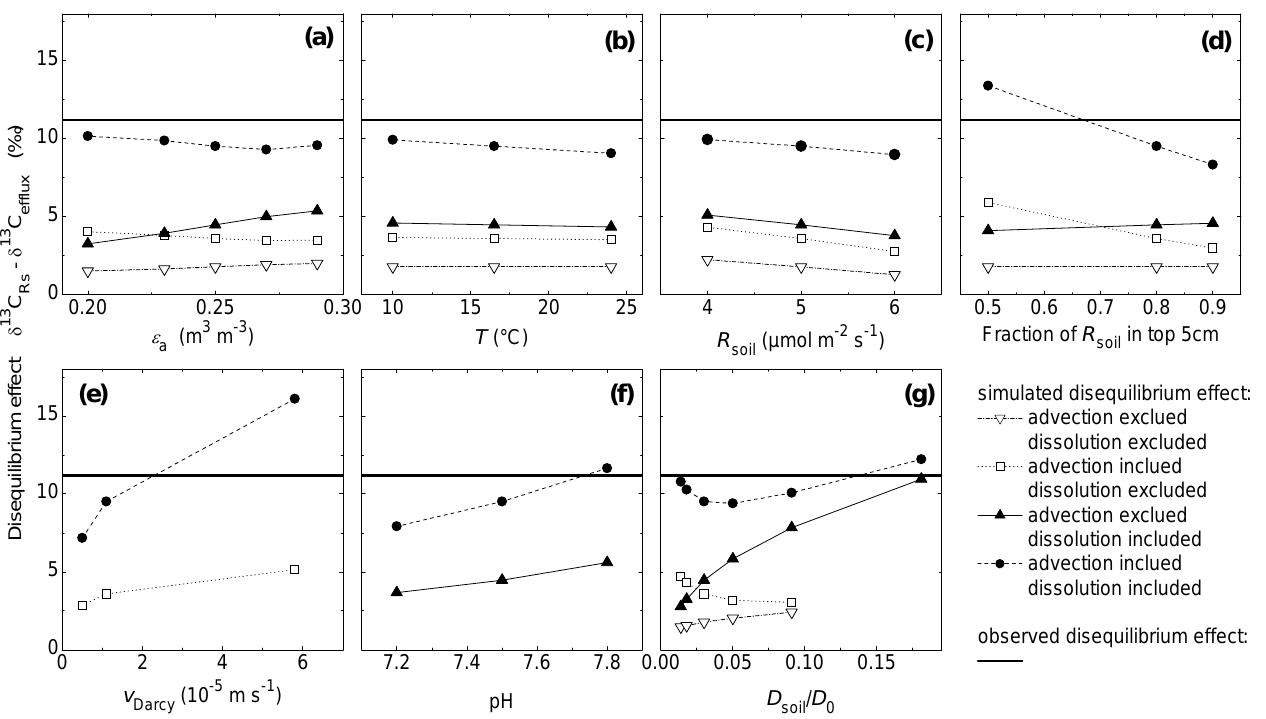
Fig. 7. Sensitivity of simulated disequilibrium effect to variations in the model input parameters as shown in Table 1. Disequilibrium effects are shown as means during the labelling period. Simulations exclude (open symbols) or include (closed symbols) dissolution, and exclude (triangles) or include (circles and squares) advection. The observed disequilibrium effect is indicated by the thick solid line. The investigated parameters include (a) air-filled porosity (which covaried with water-filled porosity according to Table 1), (b) soil